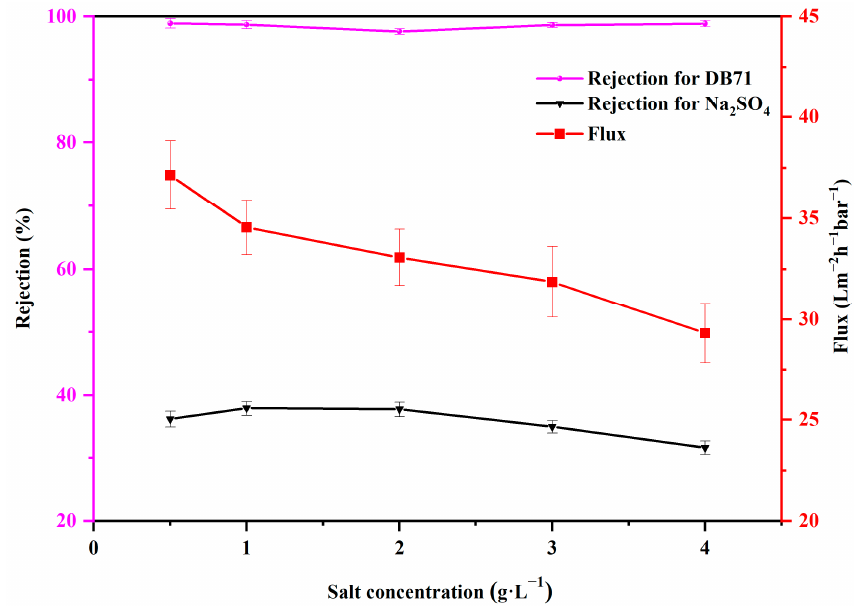
Figure 15. The e ff ect of Na 2 SO 4 concentrations (0.5~4.0 g·L − 1 ) with 0.2 g·L − 1 DB71 solution on PES– Figure 15. The effect of Na 2 SO 4 concentrations (0.5~4.0 g · L − 1 ) with 0.2 g · L − 1 DB71 solution on DPS–1 separation performance. PES–DPS–1 separation